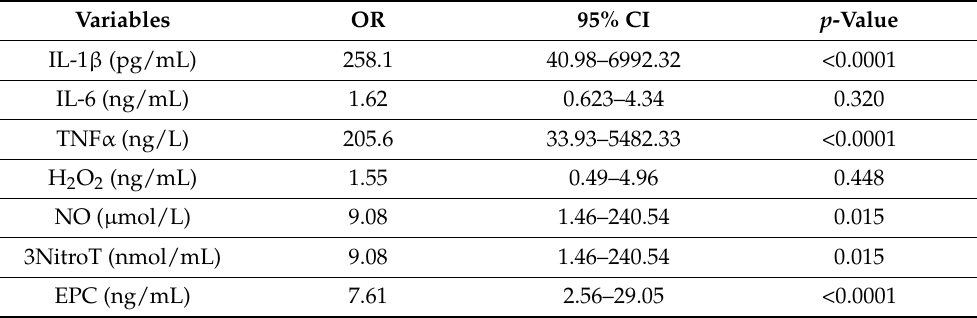
Table 6. The odds ratios for the distribution of inflammatory and endothelium-specific variables. The parameter ranges given in the rows of the contingency tables were determined based on the cut-off values calculated on the ROC